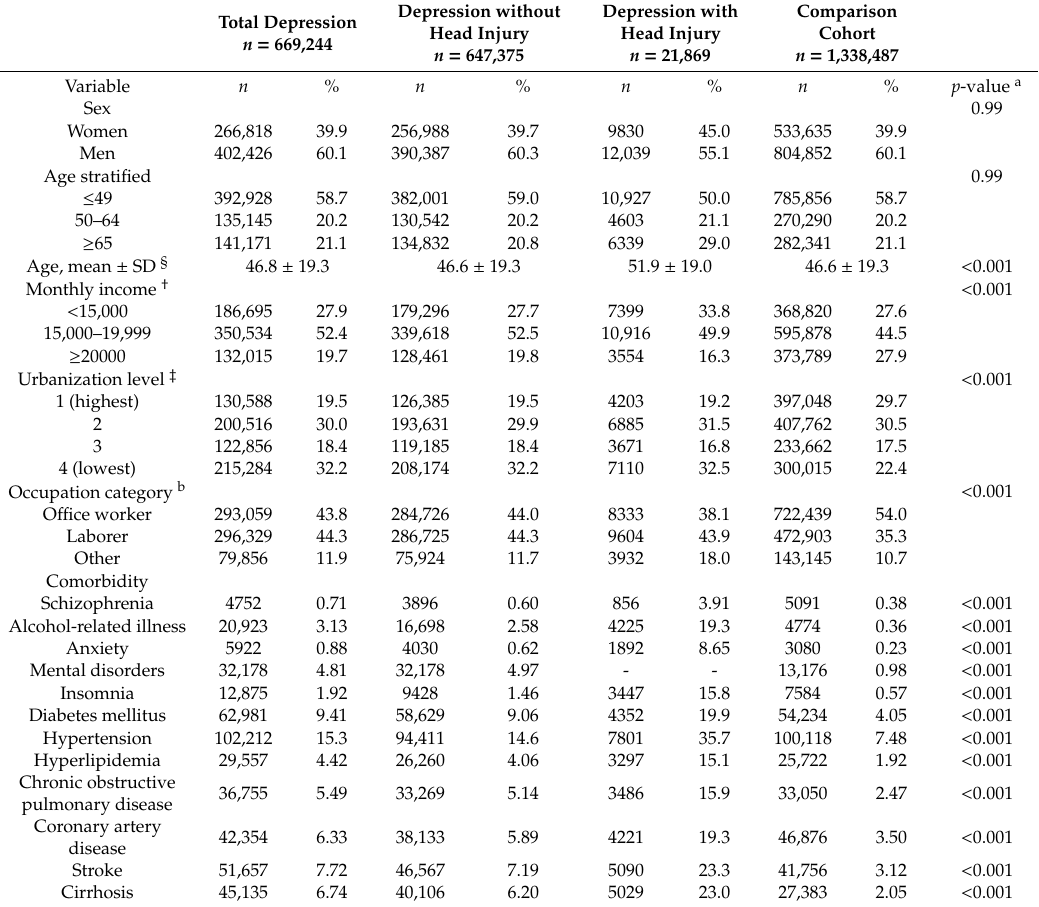
Table 1. Distribution of age, sex, and comorbidities between the depression and comparison cohorts.